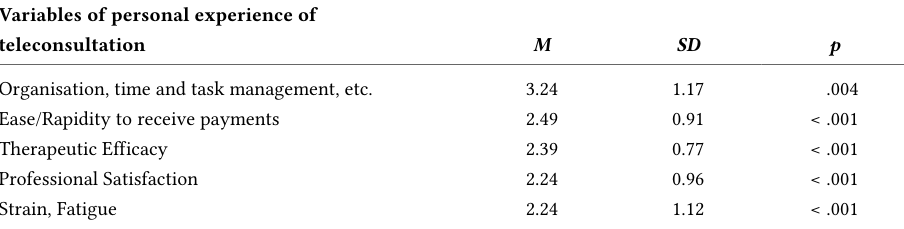
Experience of Teleconsultation as Compared to Face-to-Face (n = 206) (1: much worse; 3: no difference, 5: much better) Variables of personal experience of teleconsultation M SD p Organisation, time and task management,